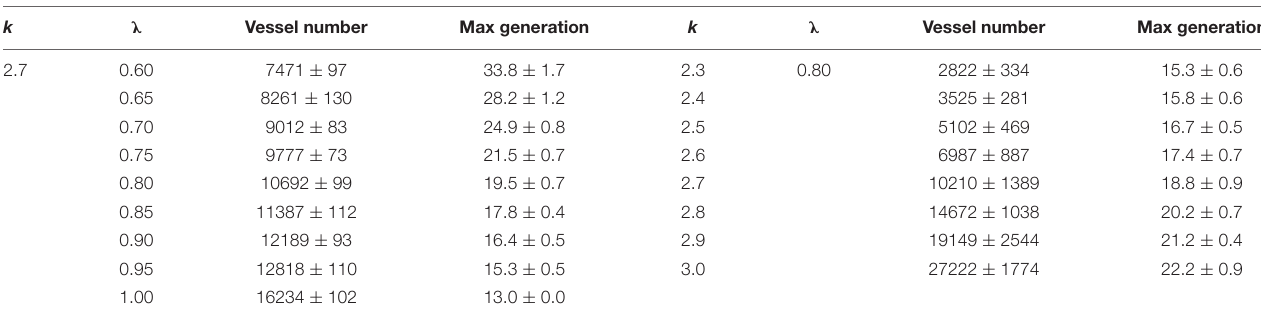
FIGURE 6 | The change of different parameters of the blood flow in the perfect binary vascular trees with different maximal generations. (A) The fractal dimension. (B) The coefficient of variation. TABLE 1 | The characteristics of the constructed vascular